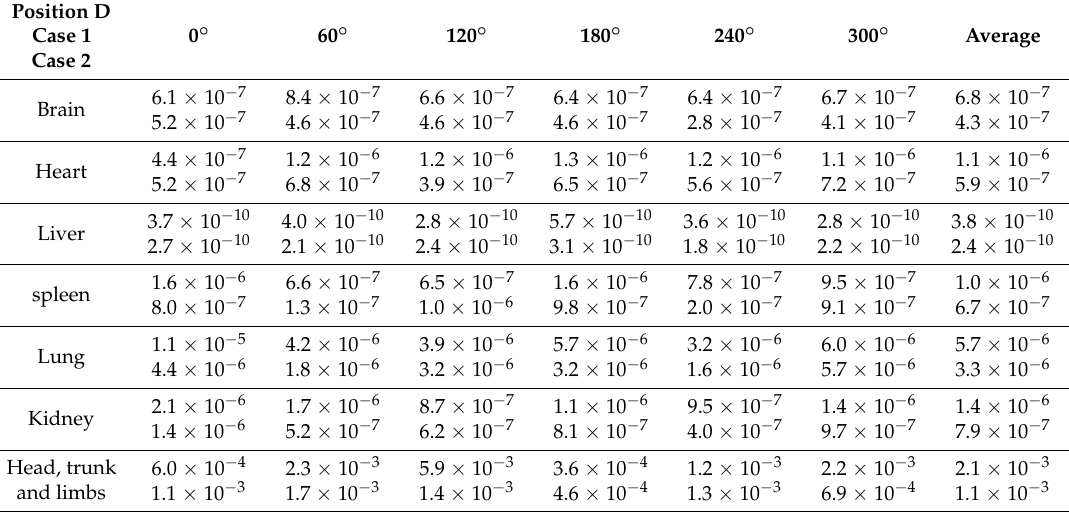
Table 7. The peak spatial-average SAR values (W/kg) in typical tissues with different orientations in position